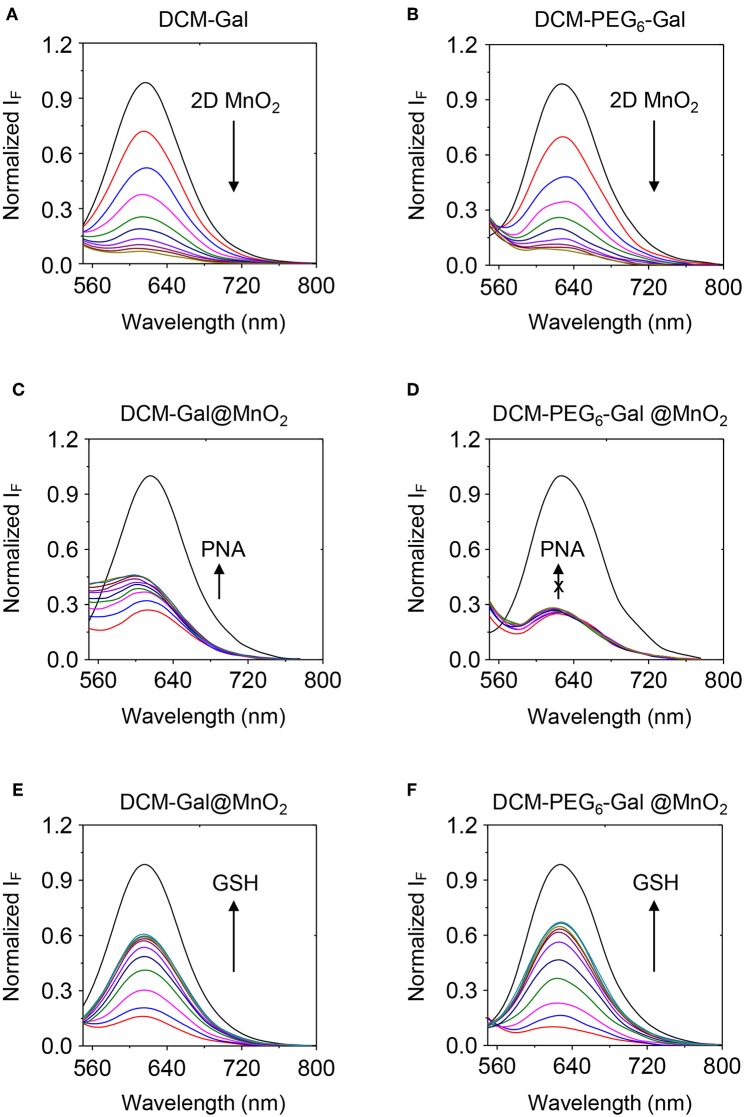
Fluorescence spectra of (A) DCM-Gal (10 μM) and (B) DCM-PEG6-Gal (10 μM) with increasing thin-layer MnO2 (from top to bottom curve: 0–40 μg ml−1, interval: 4 μg ml−1). Fluorescence spectra of (C) DCM-Gal@MnO2 (DCM-Gal/MnO2 = 10 μM/40 μg ml−1) and (D) DCM-PEG6-Gal@MnO2 (DCM-PEG6-Gal/MnO2 = 10 μM/20 μg ml−1) with increasing PNA (peanut agglutinin, from bottom to top curve: 0–40 μM, interval: 5 μM). Fluorescence spectra of (E) DCM-Gal@MnO2 (DCM-Gal/MnO2 = 10 μM/40 μg ml−1) and (F) DCM-PEG6-Gal@MnO2 (DCM-PEG6-Gal/MnO2 = 10 μM/40 μg ml−1) with increasing GSH (γ-glutathione, from bottom to top curve: 0–500 μM, interval: 50 μM).